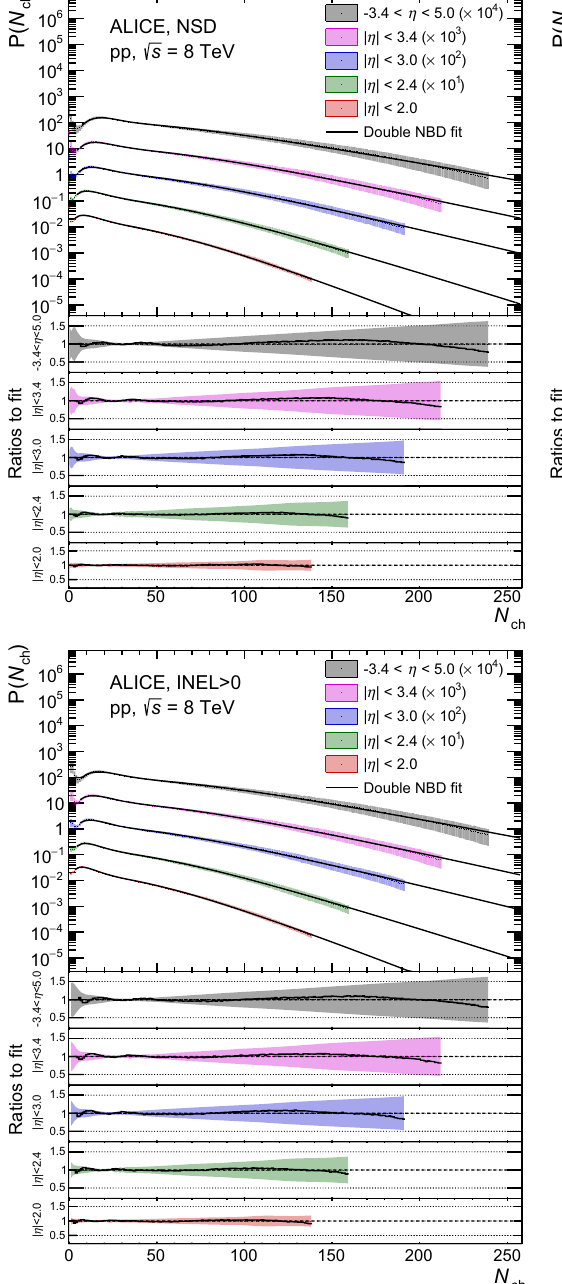
presented. Combined systematic and statistical uncertainties are shown √ s = 8 TeV. as bands